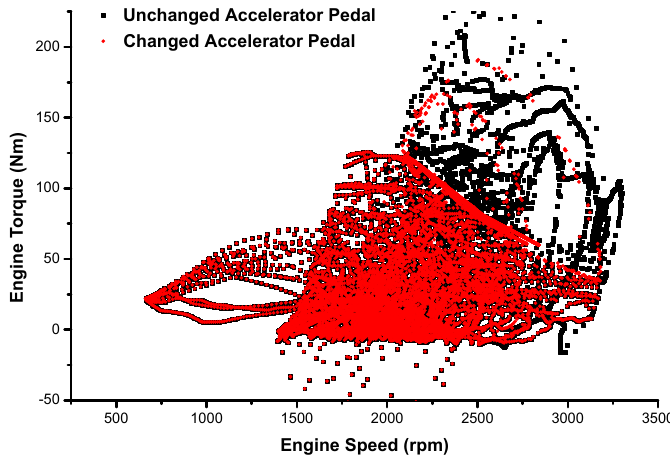
Figure 10. Comparison of engine working point in changing driving style.